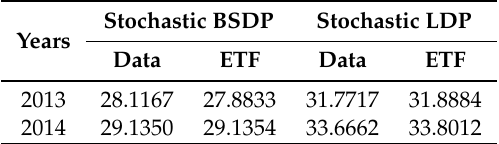
Table 6. Predictions from trend functions of the stochastic BSDP and LDP processes.